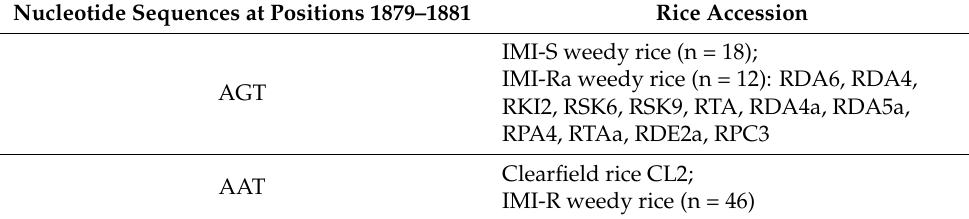
Table 2. Nucleotide and amino acid changes differentiating the majority of the IMI-R with IMI-S weedy